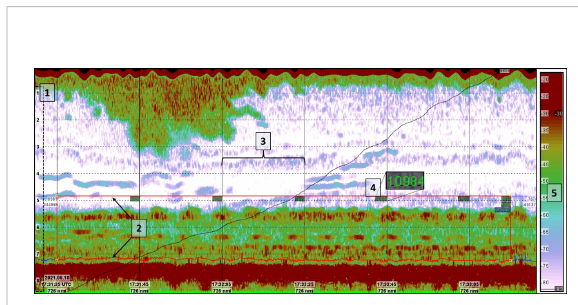
FIGURE 4 Example of echogram as viewed in the LSSS software. The acoustic data displayed are collected from Vikna station 136. 1) Vertical depth markers measured from the transducer acoustically. 2) Lower and upper integration lines de fi ne a region from which the nautical area backscatter coef fi cient (NASC- value) of the kelp forest is calculated. 3) Vertical lines on the echogram divide the pings into 100-ping segments. 4) NASC- value for each 100-ping bin is displayed directly in the echogram and written to a database. 5) Colour bar showing the volumetric